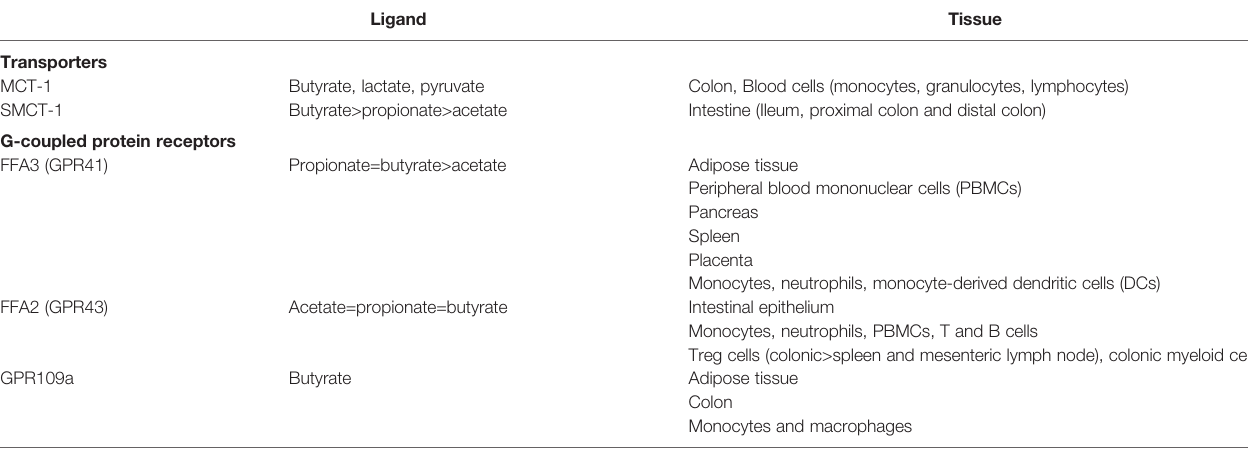
TABLE 3 | SCFA transporters and receptors and tissue distribution in humans. Ligand Tissue Transporters MCT-1 Butyrate, lactate,